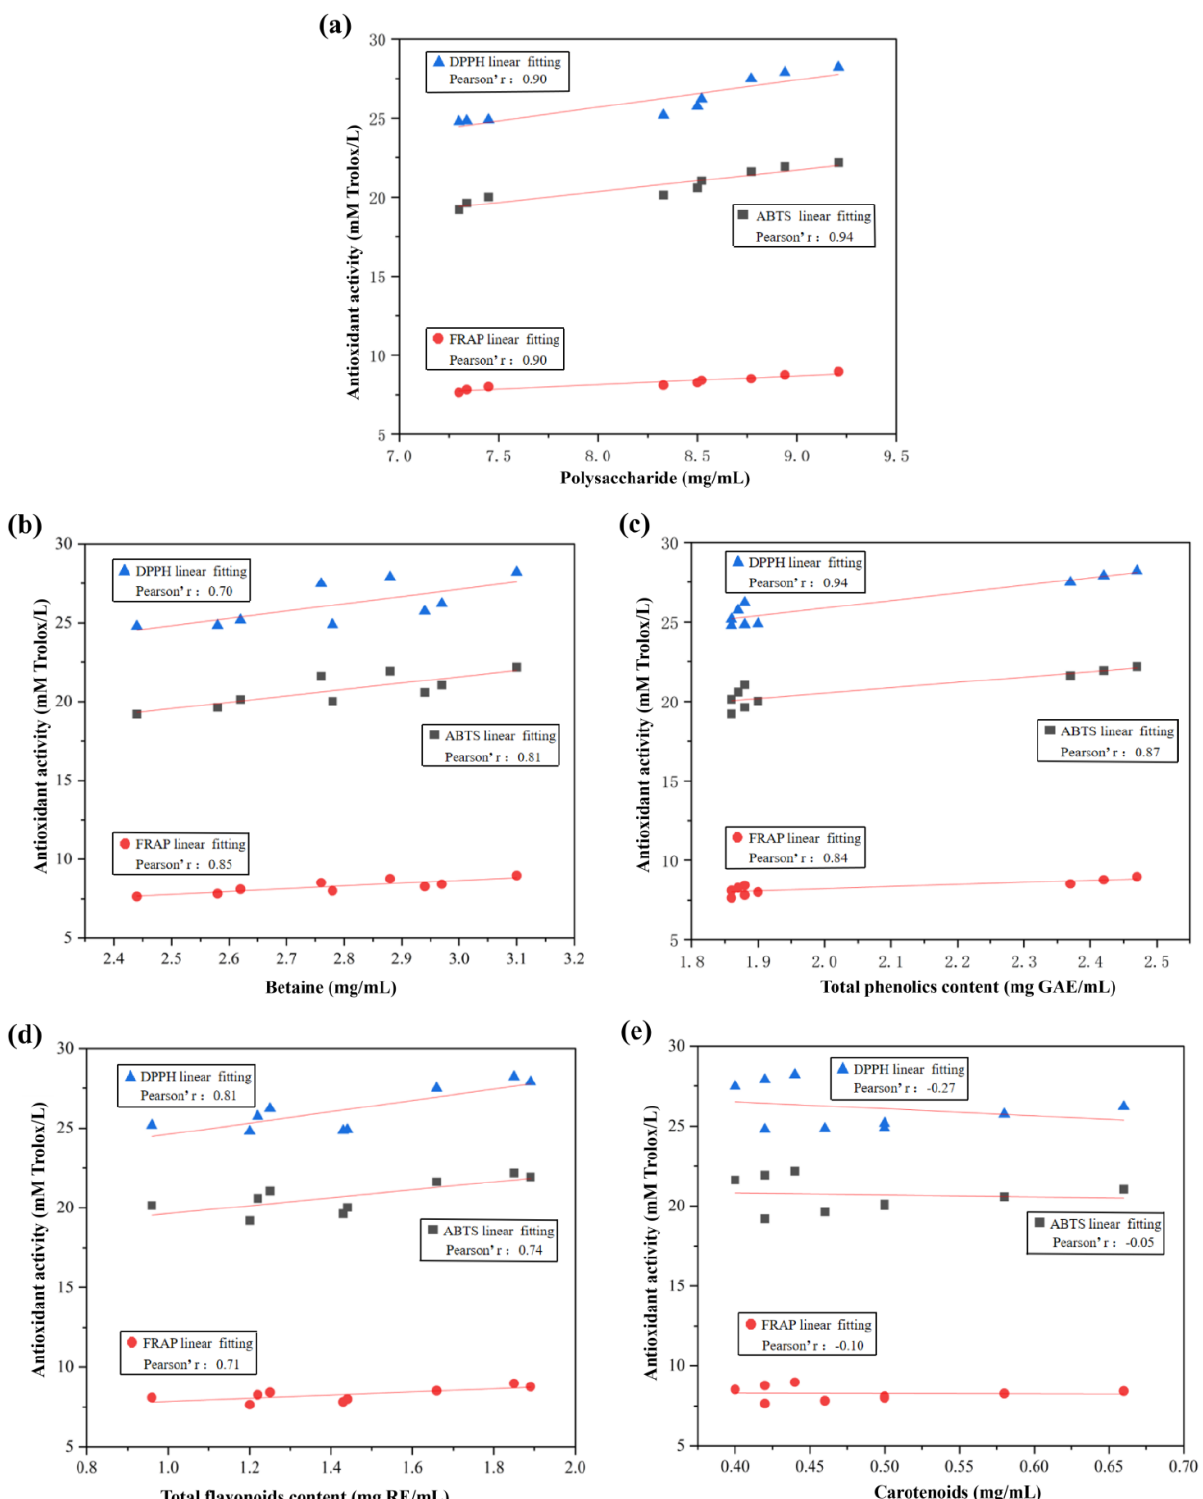
Figure 2. Correlation analysis of bioactive ingredients and antioxidant activity during the fermenta- tion processes: ( a ) polysaccharide, ( b ) betaine ( c ) total phenolics content, ( d ) total flavonoids content, and ( e )